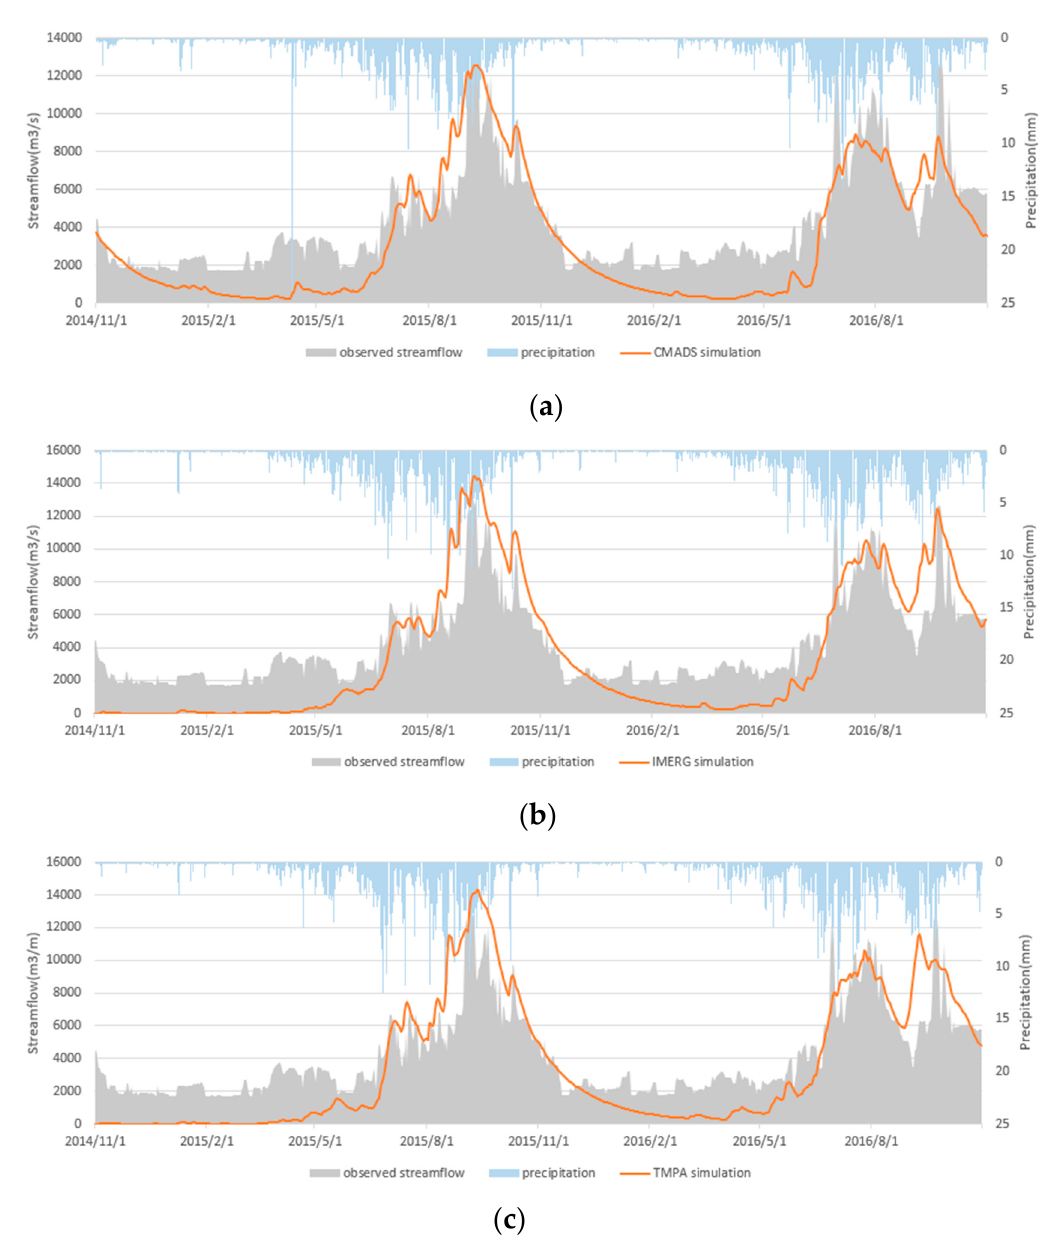
Figure 8. Comparison of runoff results from hydrological model simulation of the Jinsha River Basin